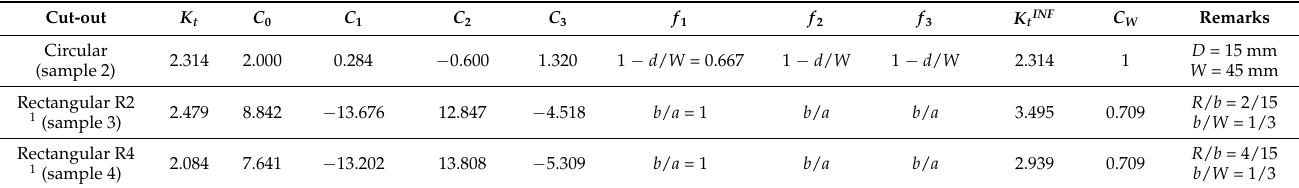
Table 4. Theoretical values of stress concentration factors for investigated